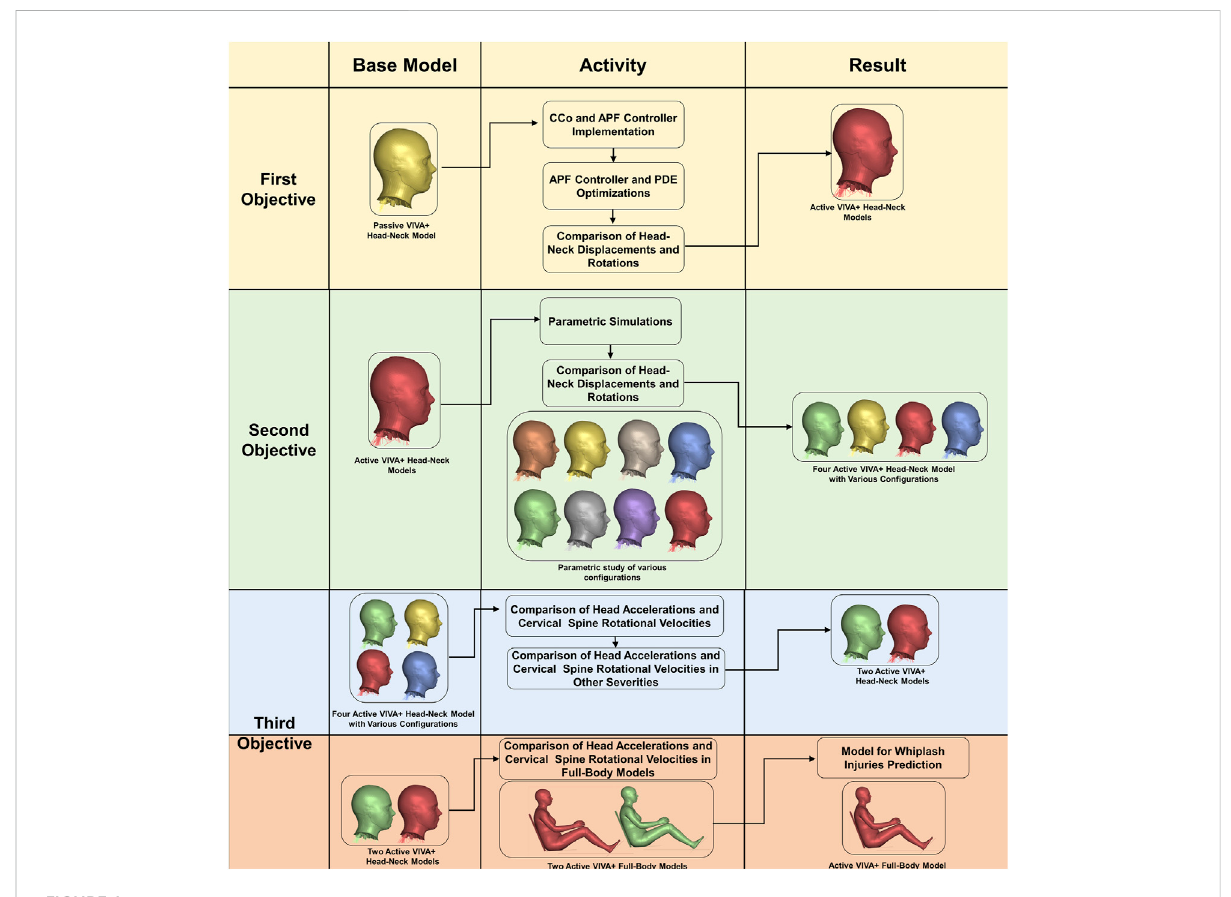
FIGURE 1 Flow chart of the methods connected to the present Study ’ s objectives.